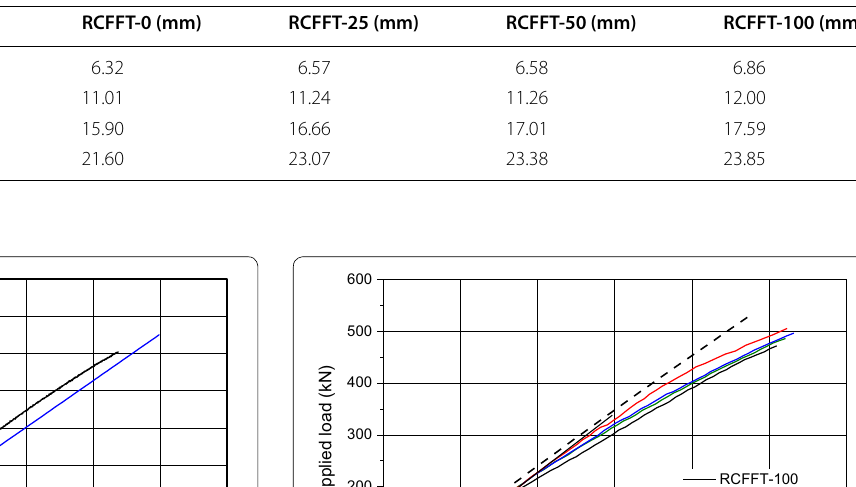
Deflection of top fiber (test) Deflection of bottom fiber (test) Deflection of top fiber (FEA) Deflection of bottom fiber (FEA)